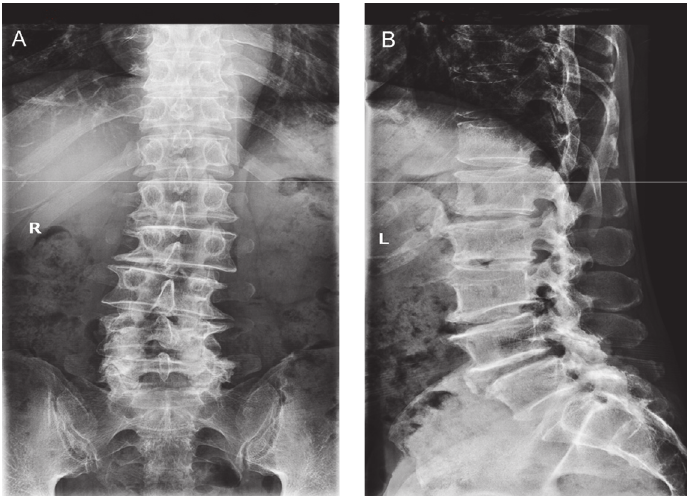
Figure 1: The preoperative anteroposterior (A) and left lateral (B) X-ray images of the patient, showing lumbar scoliosis, lumbar degeneration, and vertebral instability.